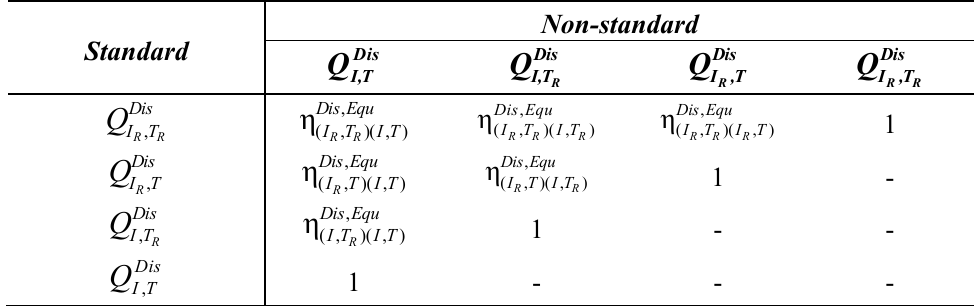
Table 5. Equivalent discharge coulombic efficiency at different conditions.